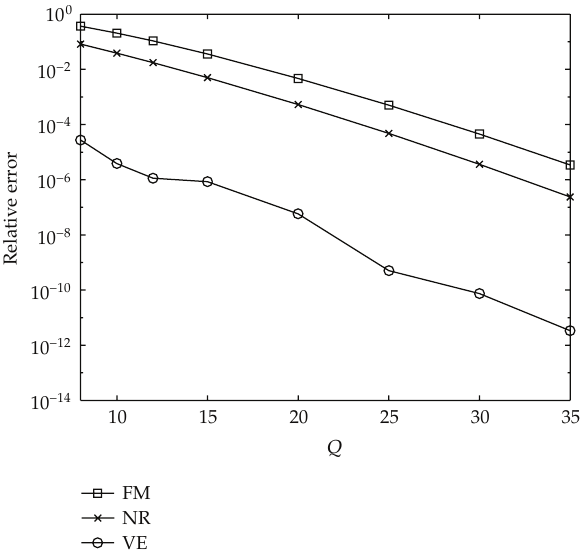
Figure 6: Relative error in P ns for di ff erent